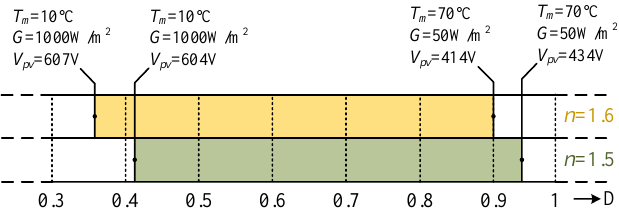
Figure 10. Variation range of duty cycle, D , for the practical MPPT converter as a function of n in between extreme operating conditions.